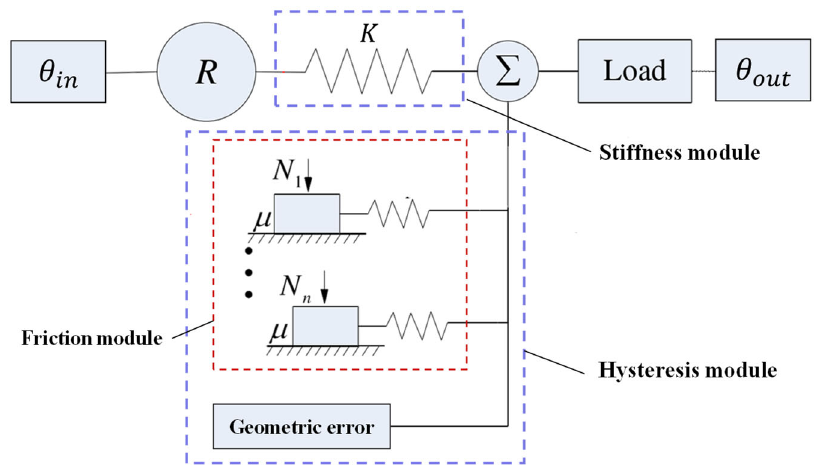
Figure 3. Hysteresis model structure of reducer.